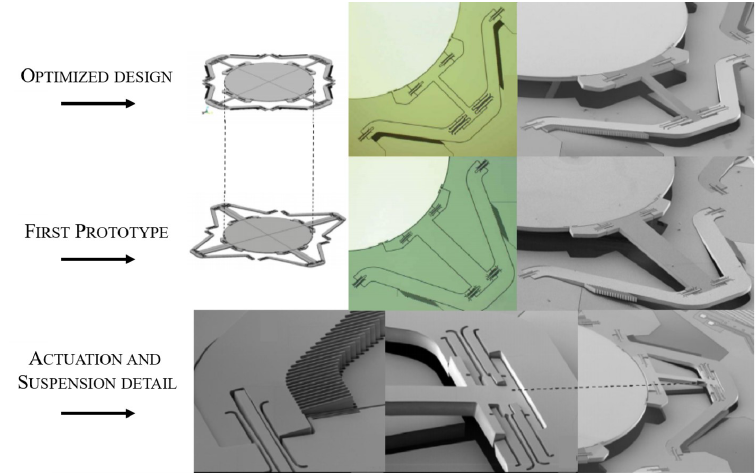
Figure 3. Graphical comparison of the preliminary and optimized mirror design, and details of the actuation and suspension. Adapted from [6] c (cid:13) SPIE